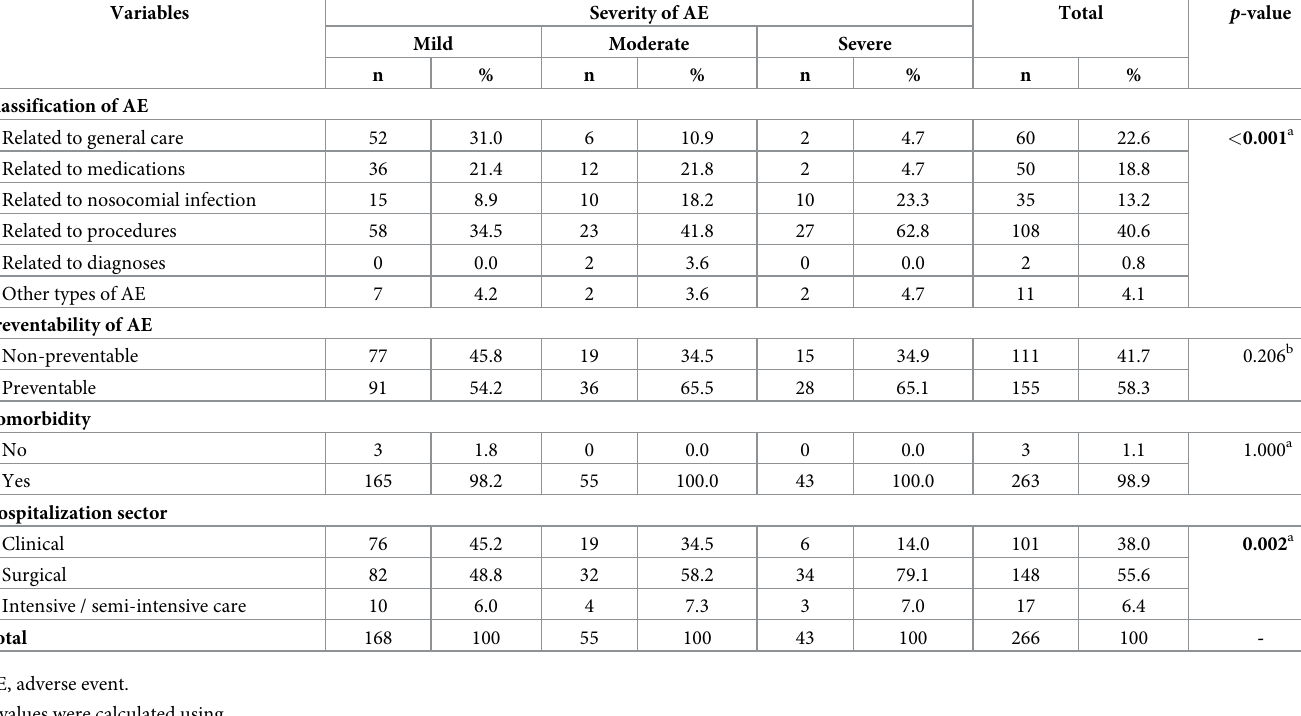
Table 3. Associations between the severity categories of adverse events and the variables classification of the events according to their nature, preventability, comor- bidity and hospitalization sector. Variables